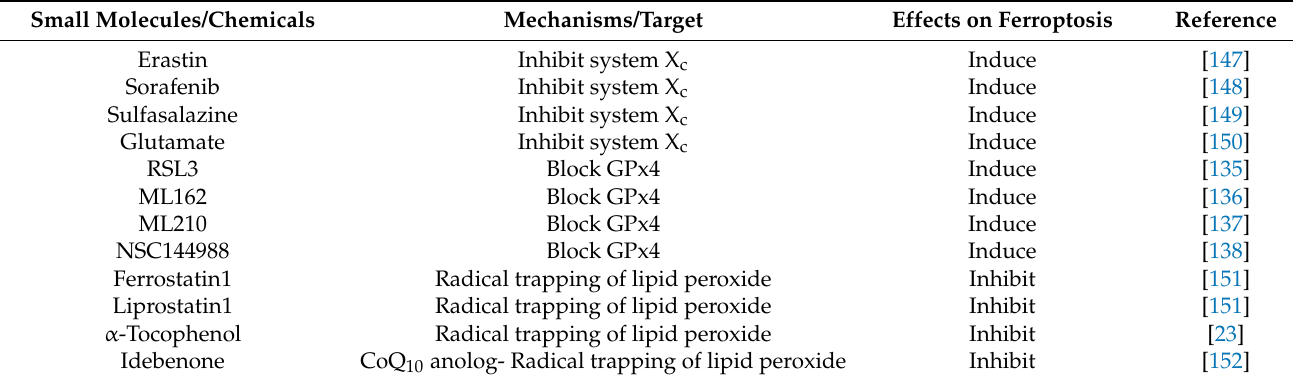
Table 1. Inducers and inhibitors of